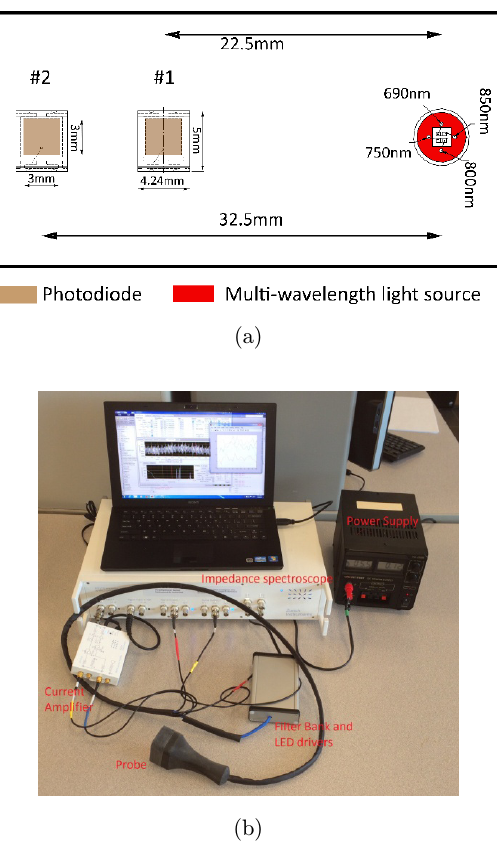
Fig. 1. (a) Source-detector con¯guration on the probe, and (b) Photograph of the radio frequency eLED light modulated DOS.